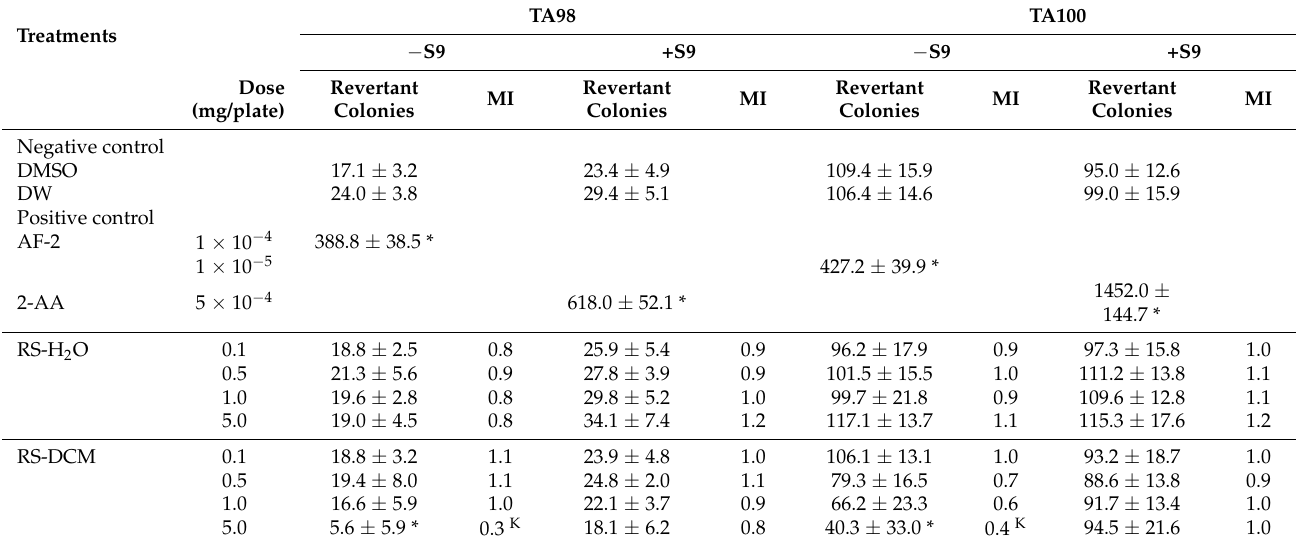
Table 6. In vitro mutagenic activities of RS extract in TA98 and TA100 strains of S. Typhimurium with non-metabolic ( − S9) and metabolic (+S9) activation.